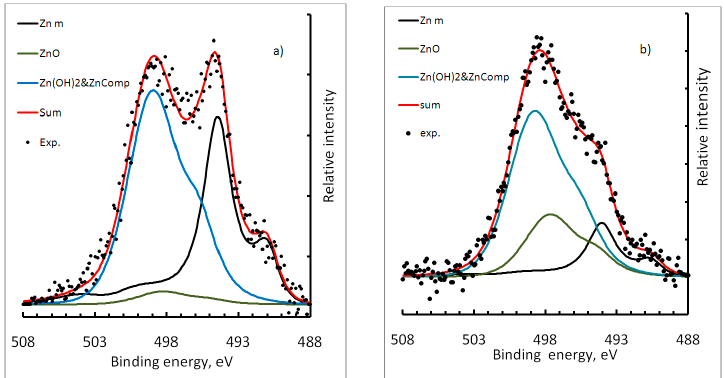
Figure 7. Deconvolution of the Auger ZnLMM spectra into individual components for samples exposed in 0.01 mM MPATA solution after 1 min ( a ) and after 17 h ( b ).